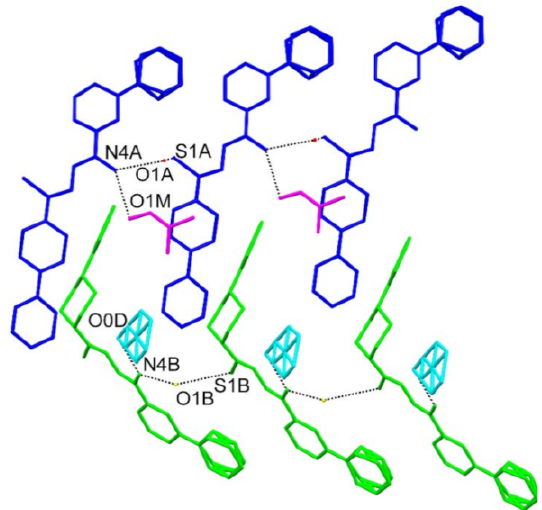
Figure 7. The intermolecular hydrogen bonds in compound 4 .